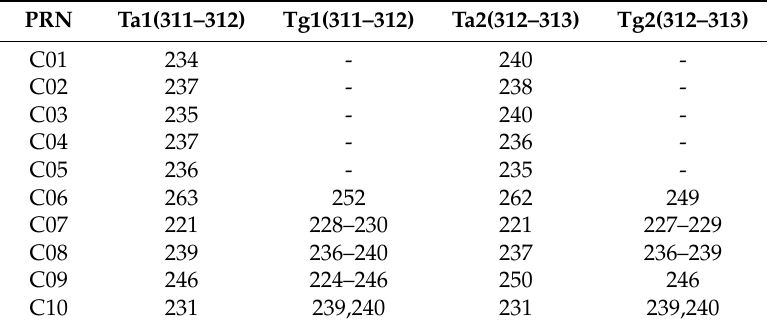
Table 1. Time shift of GEO and IGSO over two consecutive days (unit: s).